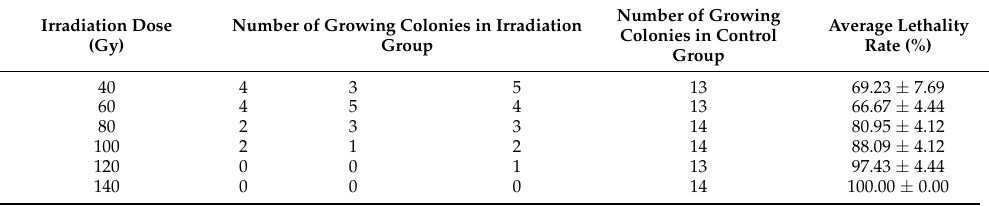
Table 6. Lethality rate of A. oxytropis after irradiation with 12 C 6+ heavy-ion